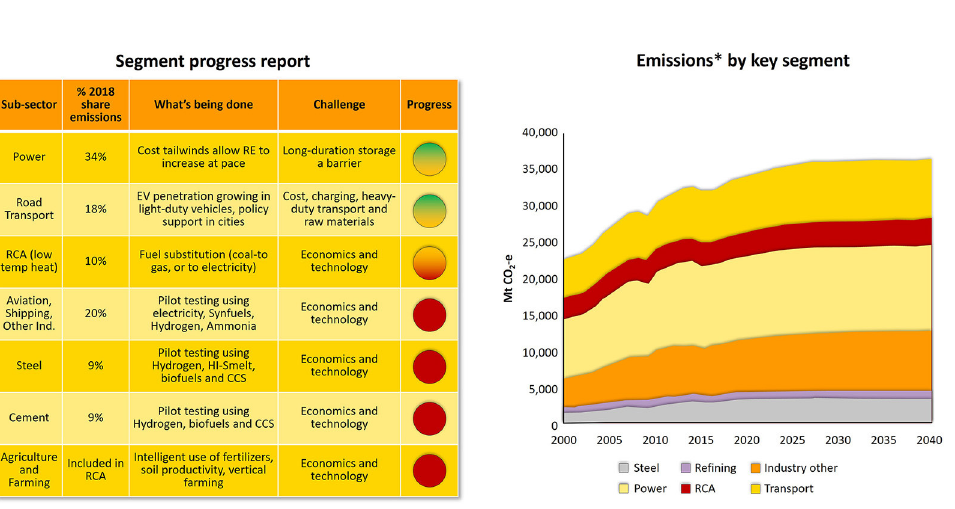
Fig. 18. – Why is it so challenging to decarbonise? Some segments of the global economy are hard to decarbonise (Source: Wood Mackenzie,